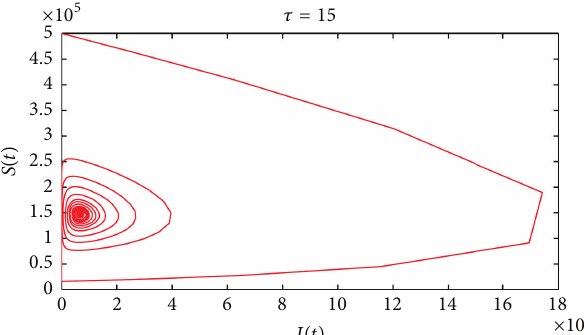
Figure 11: The phase portrait of susceptible 𝑆(𝑡) and infected 𝐼(𝑡) when 𝜏 = 15 .